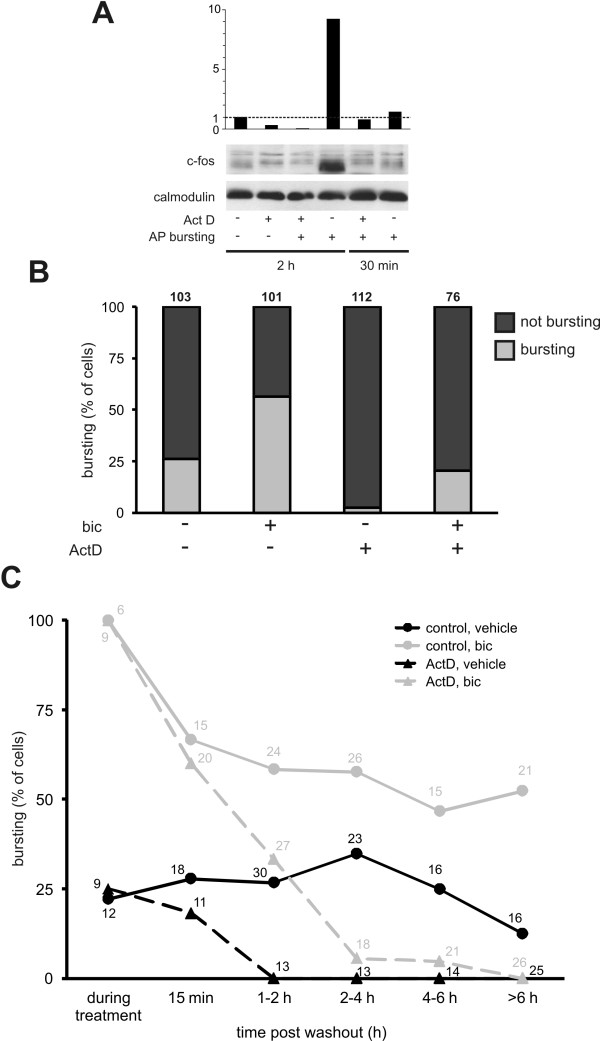
The persistence but not the induction of AP bursting over the 10 hour post induction period is transcription-dependent. (A) Western blot experiments showing the induction of the immediate-early gene c-fos either 2 hours or 30 minutes after a 15 minute period of bicuculline (50 μM) treatment in the presence or absence of actinomycin D (Act D, 8 μM). The histogram represents the intensities of the c-fos expression level relative to unstimulated control conditions. Endogenous calmodulin serves as loading control. (B) Histograms show the proportion of neurons exhibiting either bursting or random/silent activity patterns the 10 hours after a 15 min period of bicuculline or vehicle treatment in control and actinomycin D (ActD) treated neurons. Total neuron numbers in each group are indicated above each bar. (C) The bursting incidence data shown in B is separated into 6 groups to illustrate the time course of its modulation. Neuron numbers per group are indicated above each data point.